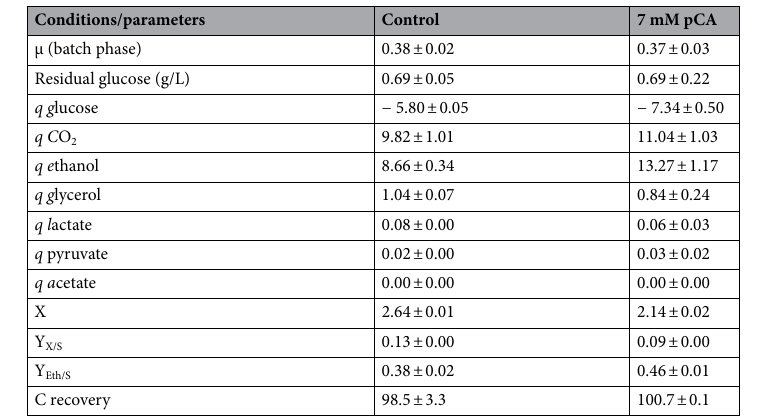
Table 1. Physiology of S. cerevisiae strains in glucose-limited anaerobic chemostats at a dilution rate of 0.1 h −1 . Specific rates ( q ) are given in mmol g −1 h −1 , µ in h −1 , yeast biomass (X) in g DW L −1 , conversion factor